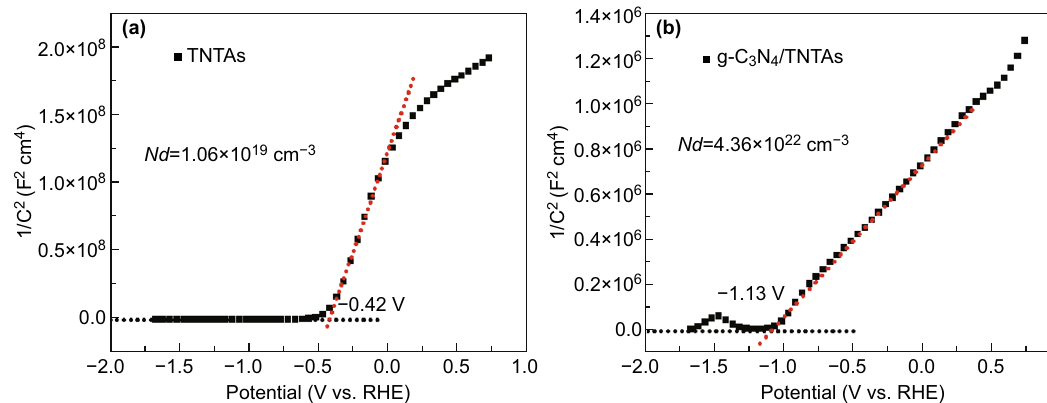
Fig. 10 Mott–Schottky images of a pristine TNTAs and b g-C 3 N 4 /TNTAs